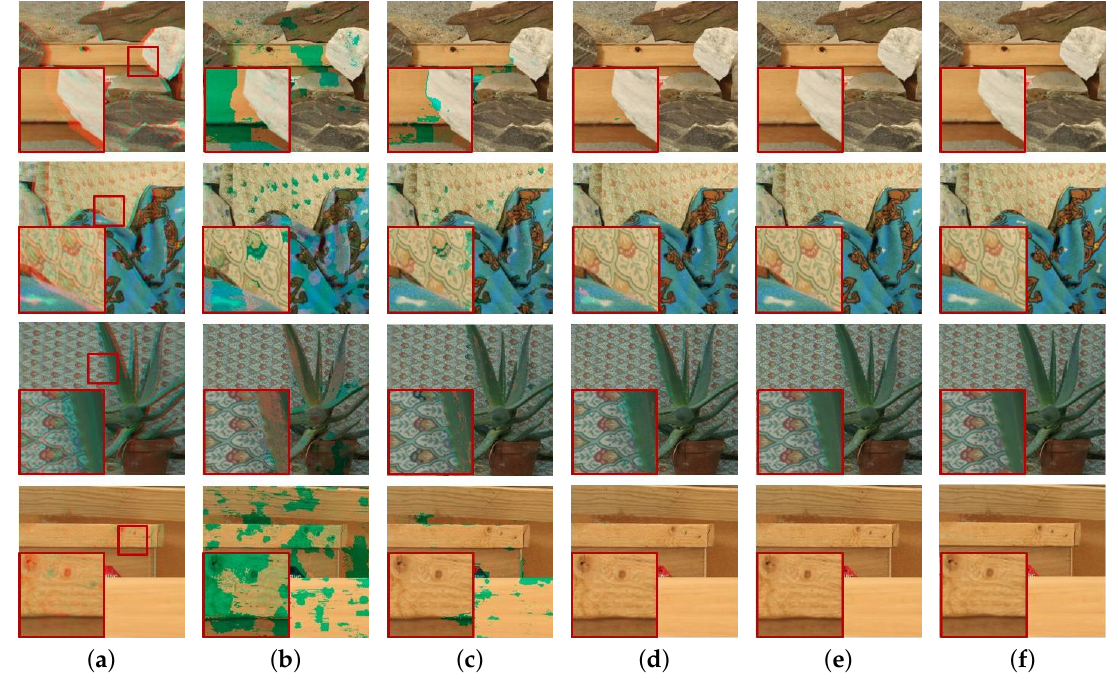
Figure 15. Color registration with the corresponding disparity prior shown in Figure 14 by using the proposed cross-channel registration and refinement strategy. ( a ) input DCA image, ( b ) registration by SAD, ( c ) NCC, ( d ) Holloway’s CCNG, ( e ) the proposed method and ( f ) the ground truth color